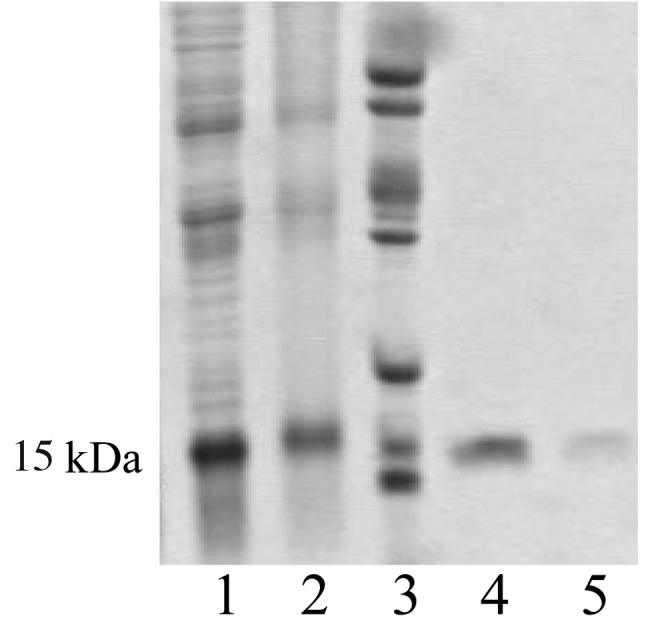
Purification of human augmenter of liver regeneration (hALR). Lanes 1 and 2: induction of SG(pQE30-hALR); lane 3: protein marker; lanes 4 and 5: purification of SG(pQE30-hALR) 15 and 5 mg/ml, respectively.